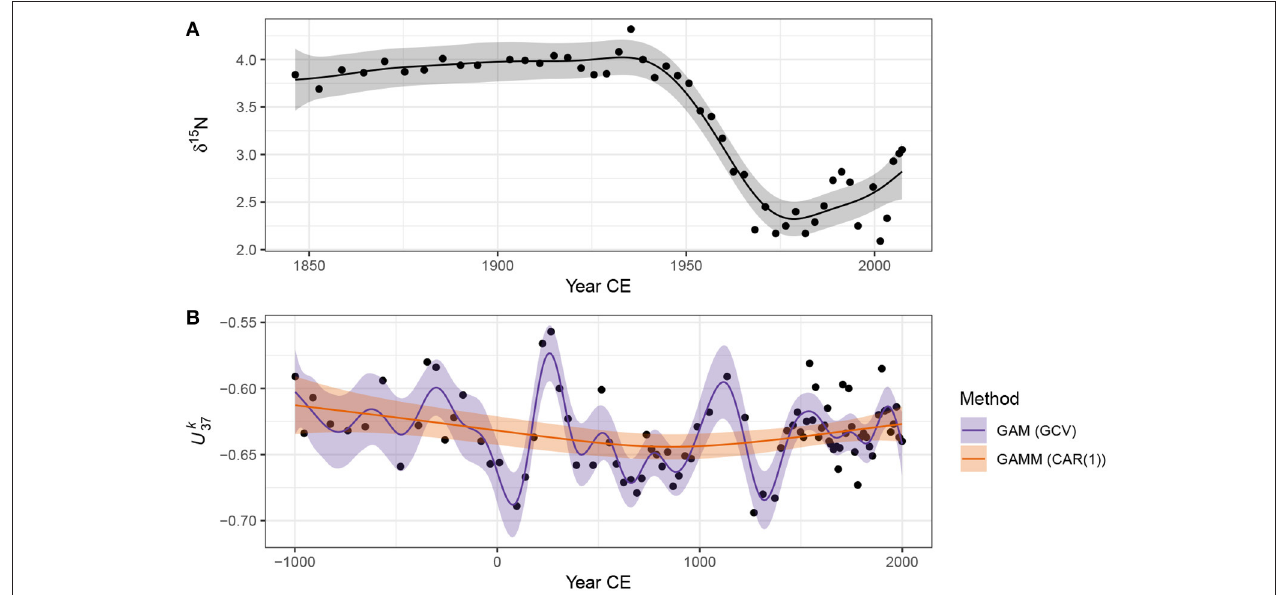
FIGURE 6 | GAM-based trends fitted to the Small Water δ 15 N (A) and Braya-Sø U K 37 (B) time series. The shaded bands surrounding the estimated trends are approximate 95% across-the-function confidence intervals. For the U K 37 series, two models are shown; the orange fit is the result of a GAM with a continuous-time AR(1) process estimated using REML smoothness selection, while the blue fit is that of a simple GAM with GCV-based smoothness selection. The REML-based fit significantly oversmooths the U K 37 time